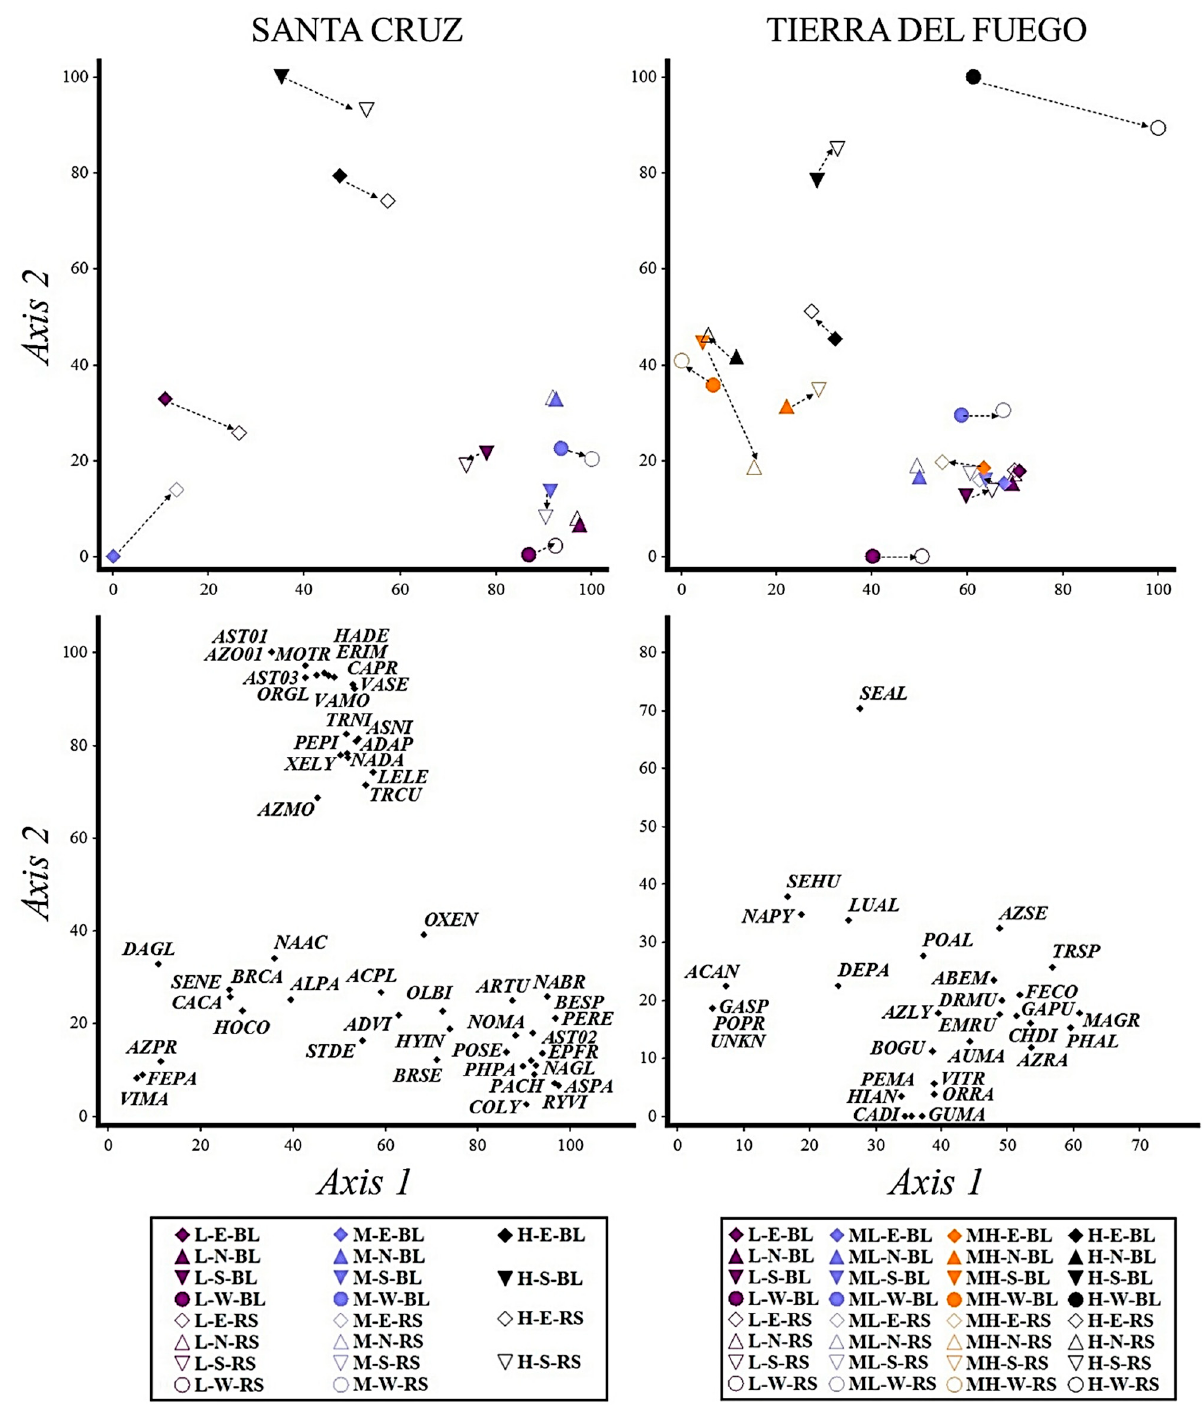
Figure 3. Non-metrical multidimensional scaling (NMS) for alpine vascular plant species assemblages in South Patagonian sites, immersed in grassland (Santa Cruz) or forest (Tierra del Fuego) landscapes. Plots (in the upper panels) are identified by summit according to their elevation (L = low, M = medium, ML = medium-low, MH = medium-high, H = high), cardinal aspect (E = east, N = north, S = south, W = west) and sampling date (BL = base line, RS = re-sampling). Species (in the lower panels), are identified by codes (see Appendix A).